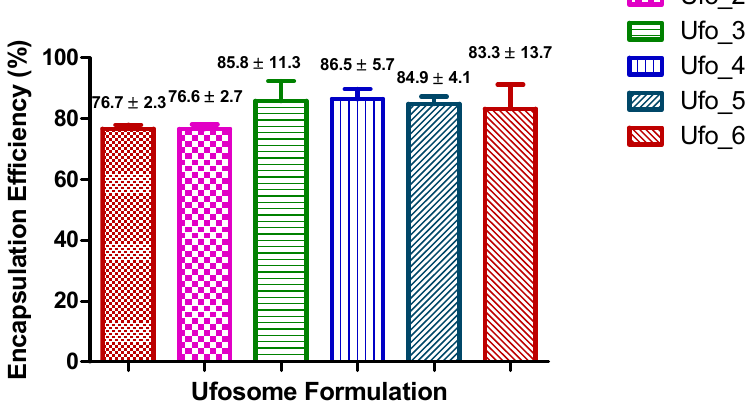
Figure 2. Summary of entrapment efficiency results of ufosomes. Data are presented as mean ± SD ( n = 3).